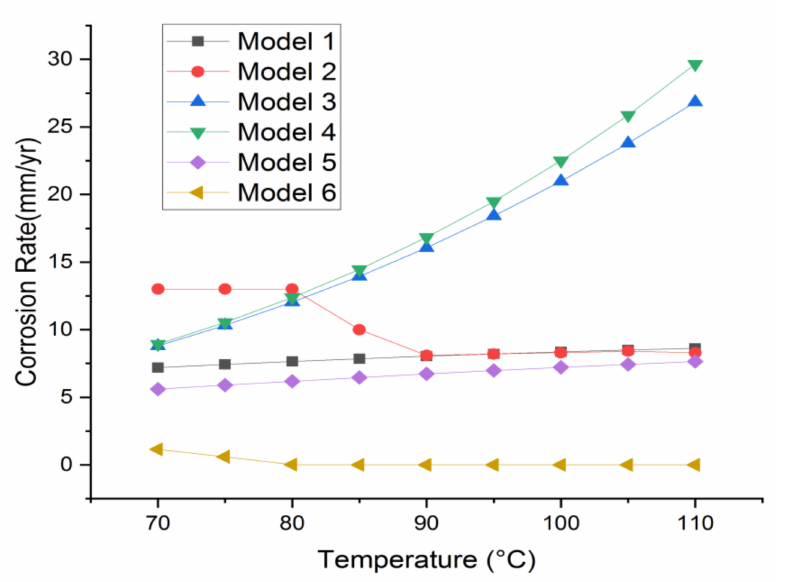
Figure 1. Different Corrosion models and predicted corrosion rates (Field data from [22] for the oil well